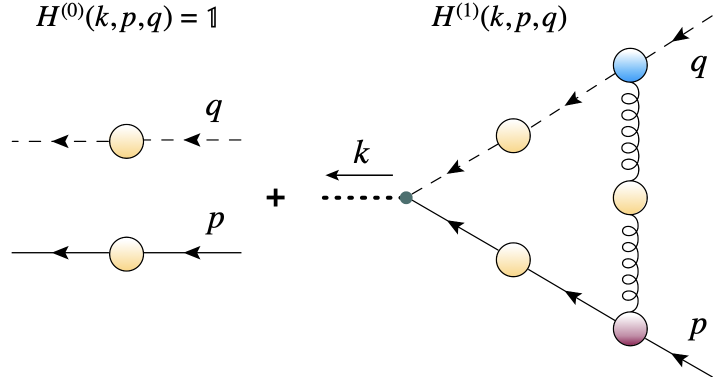
Figure 2 . Diagrammatic representation of the unconnected and connected quark-ghost scattering amplitude in its dressed one-loop approximation with the simplified kinematic choice k = q/ 2 and p = − q/ 2 . The yellow-shaded circles denote the dressed quark, gluon and ghost propagators, while the blue- and purple-shaded circles represent the dressed ghost-gluon and quark-gluon vertices, respectively. The outgoing quark and ghost propagators are joined in a non-standard